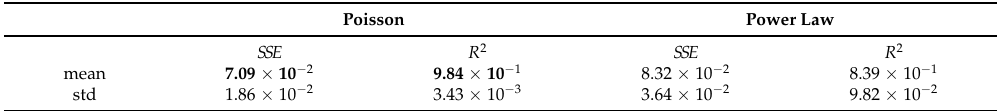
Table A1. Fitting results of